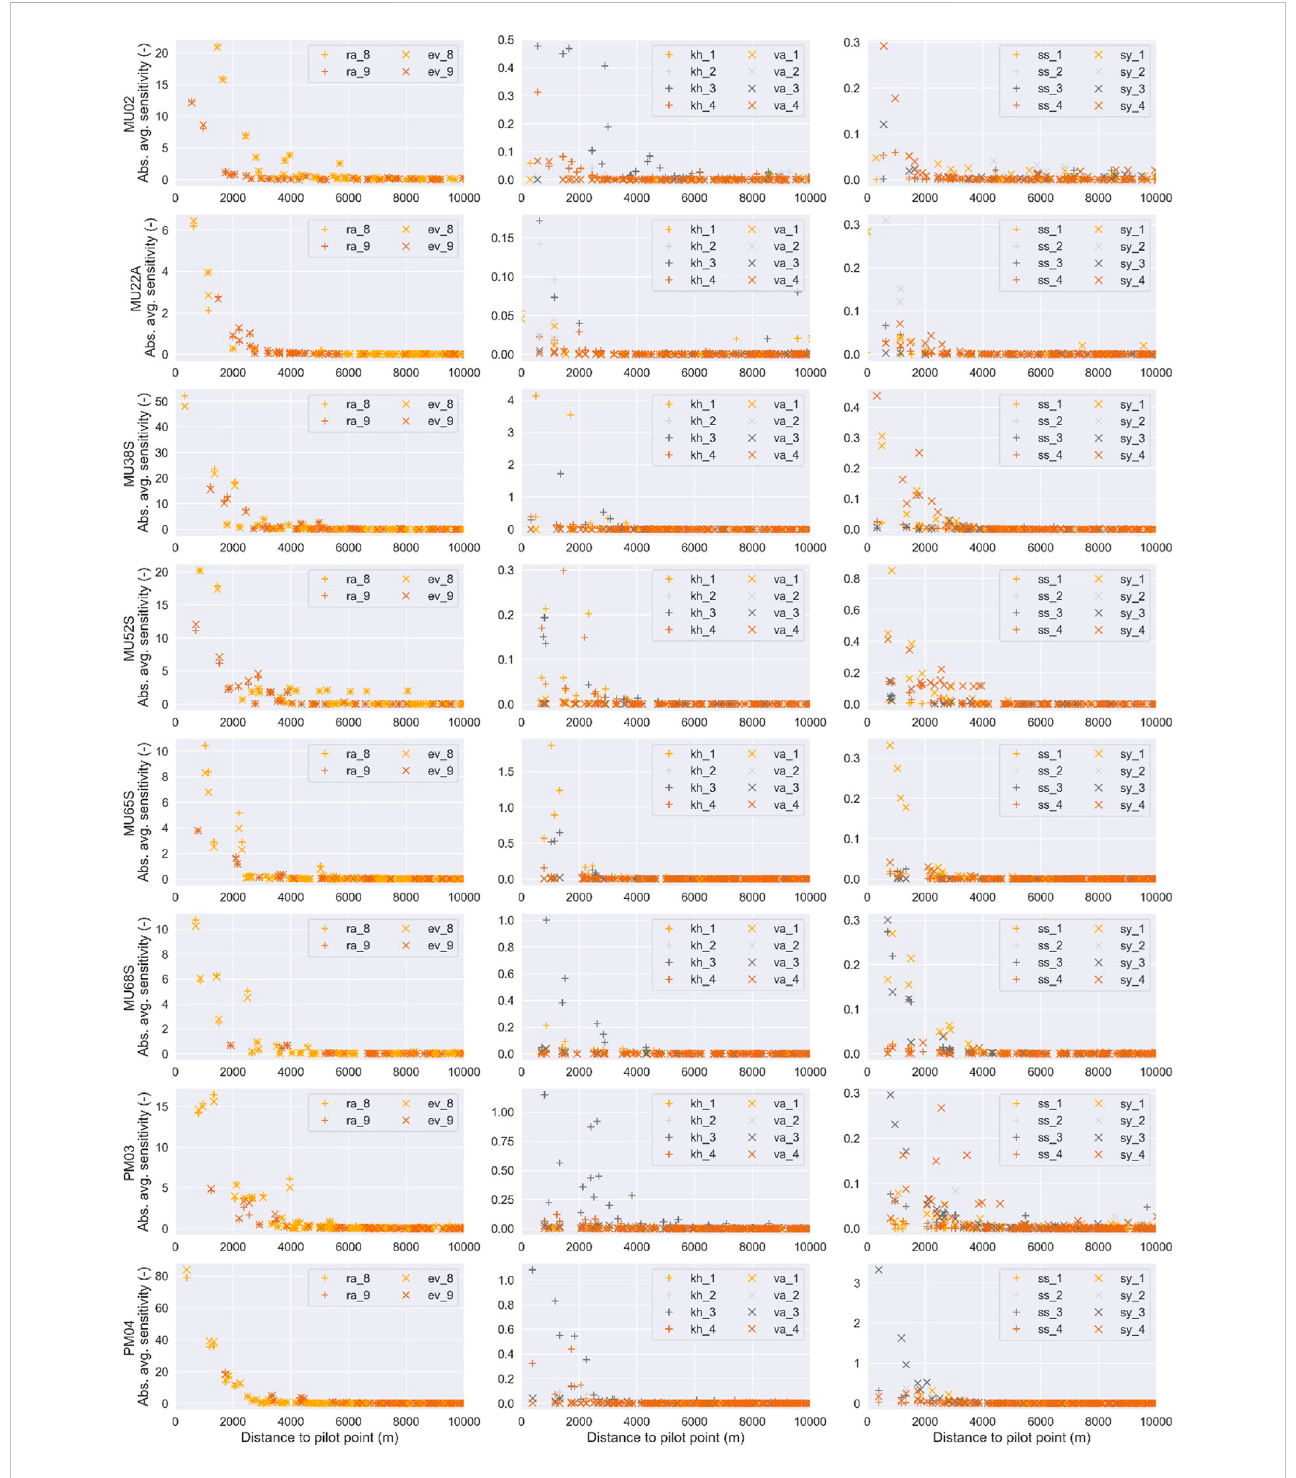
FIGURE 13 Scatter plots of absolute sensitivity values versus distance to pilot point for selected monitoring